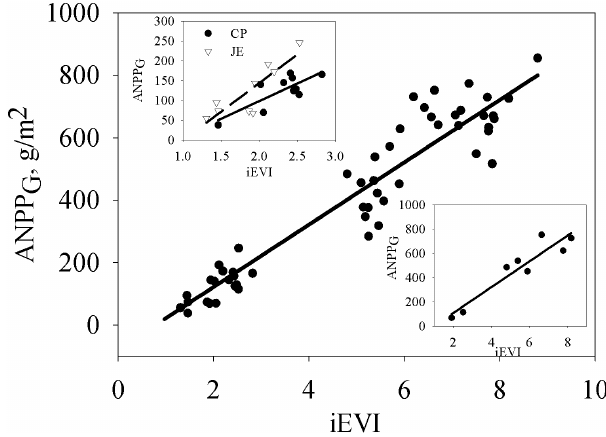
Figure 1. Relationship between annual ground measurements of ANPP (ANPP G ) and the corresponding iEVI derived from MODIS data during the period between 2000 and 2009 for nine selected sites across biomes ( R 2 = 0 . 90, P < 0 . 0001; Table 2). The upper inset shows the relationship at two sites of CP and JE ( R 2 = 0 . 63 and 0.74, respectively, P < 0.01). The lower inset shows the rela- tionship between ANPP G and iEVI for the year 2001 across the 9 sites ( R 2 = 0 . 88, P <